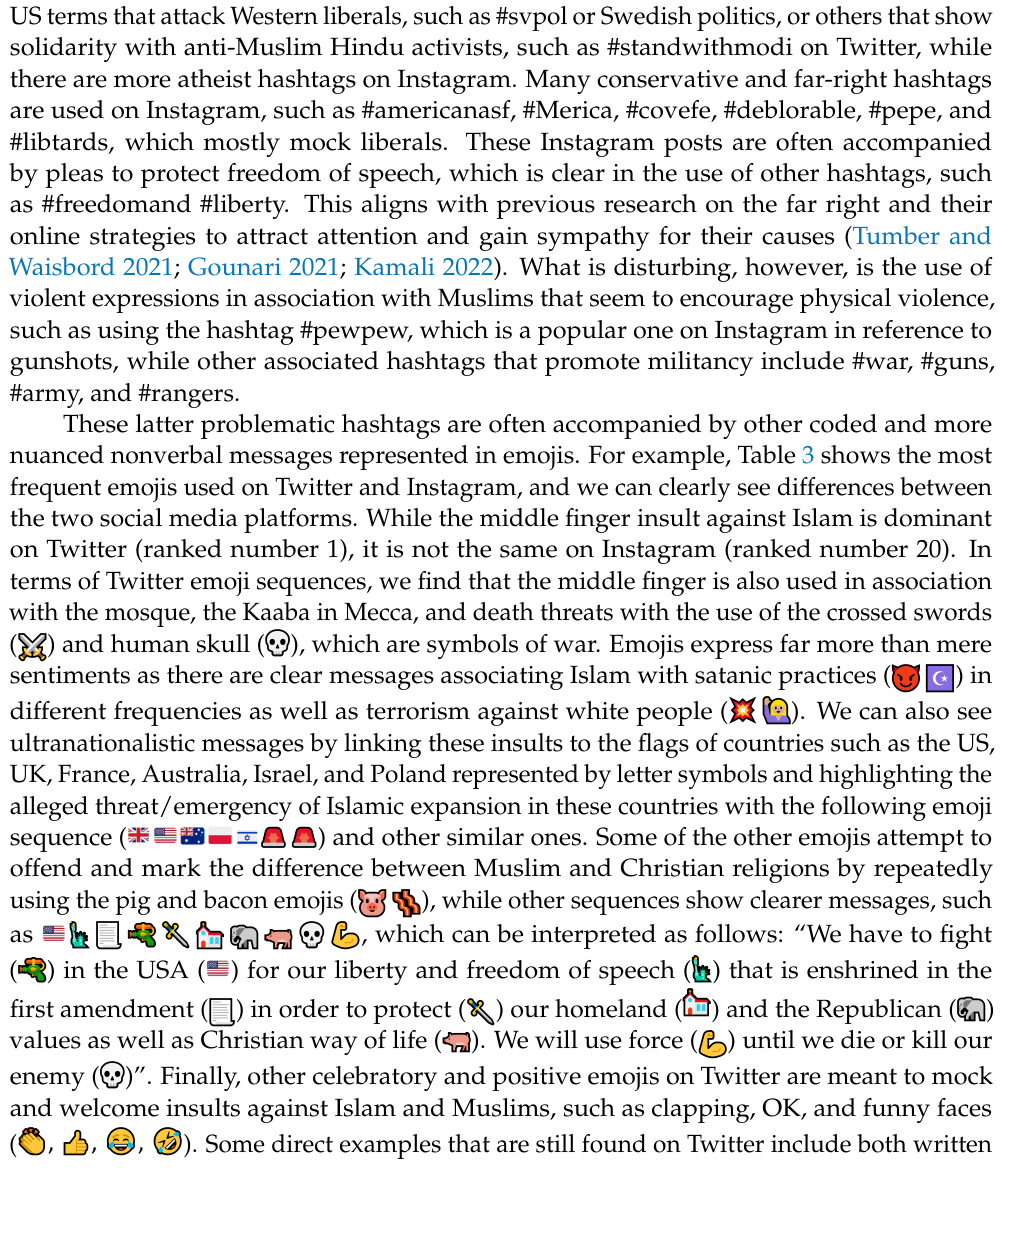
Table 3. The most frequent emojis used on Twitter and Instagram in relation to Islam. No. Twitter Count Twitter Sequence Count Instagram Count Instagram Sequence Count